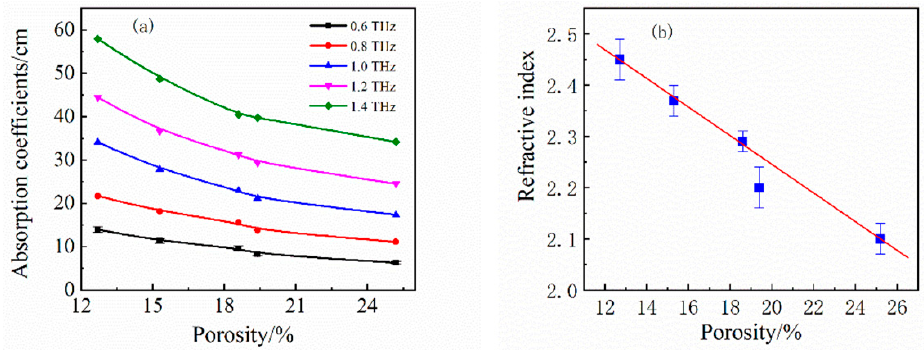
Figure 3. Absorption coefficients fit as a function of the porosity at selected frequencies ( a ) and the refractive index fits as a function of the porosity ( b ).